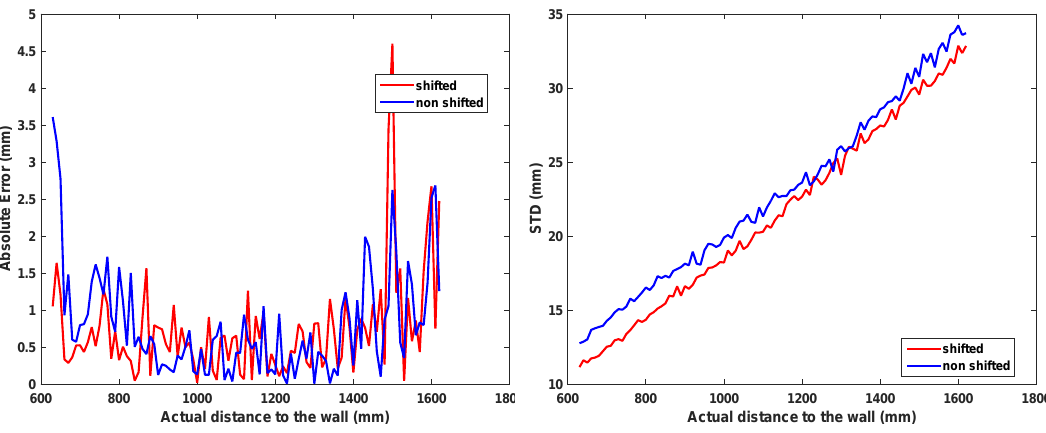
Figure 15. Distance error for the non-shifted and the shifted range measurement (left) and the corresponding SD improvement